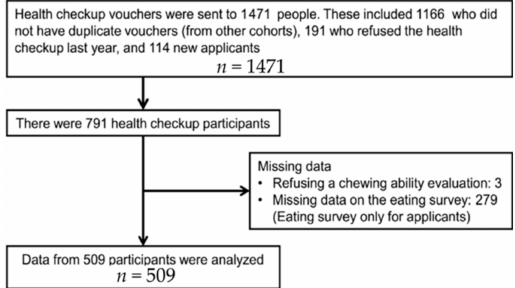
Figure 1. Recruitment of research